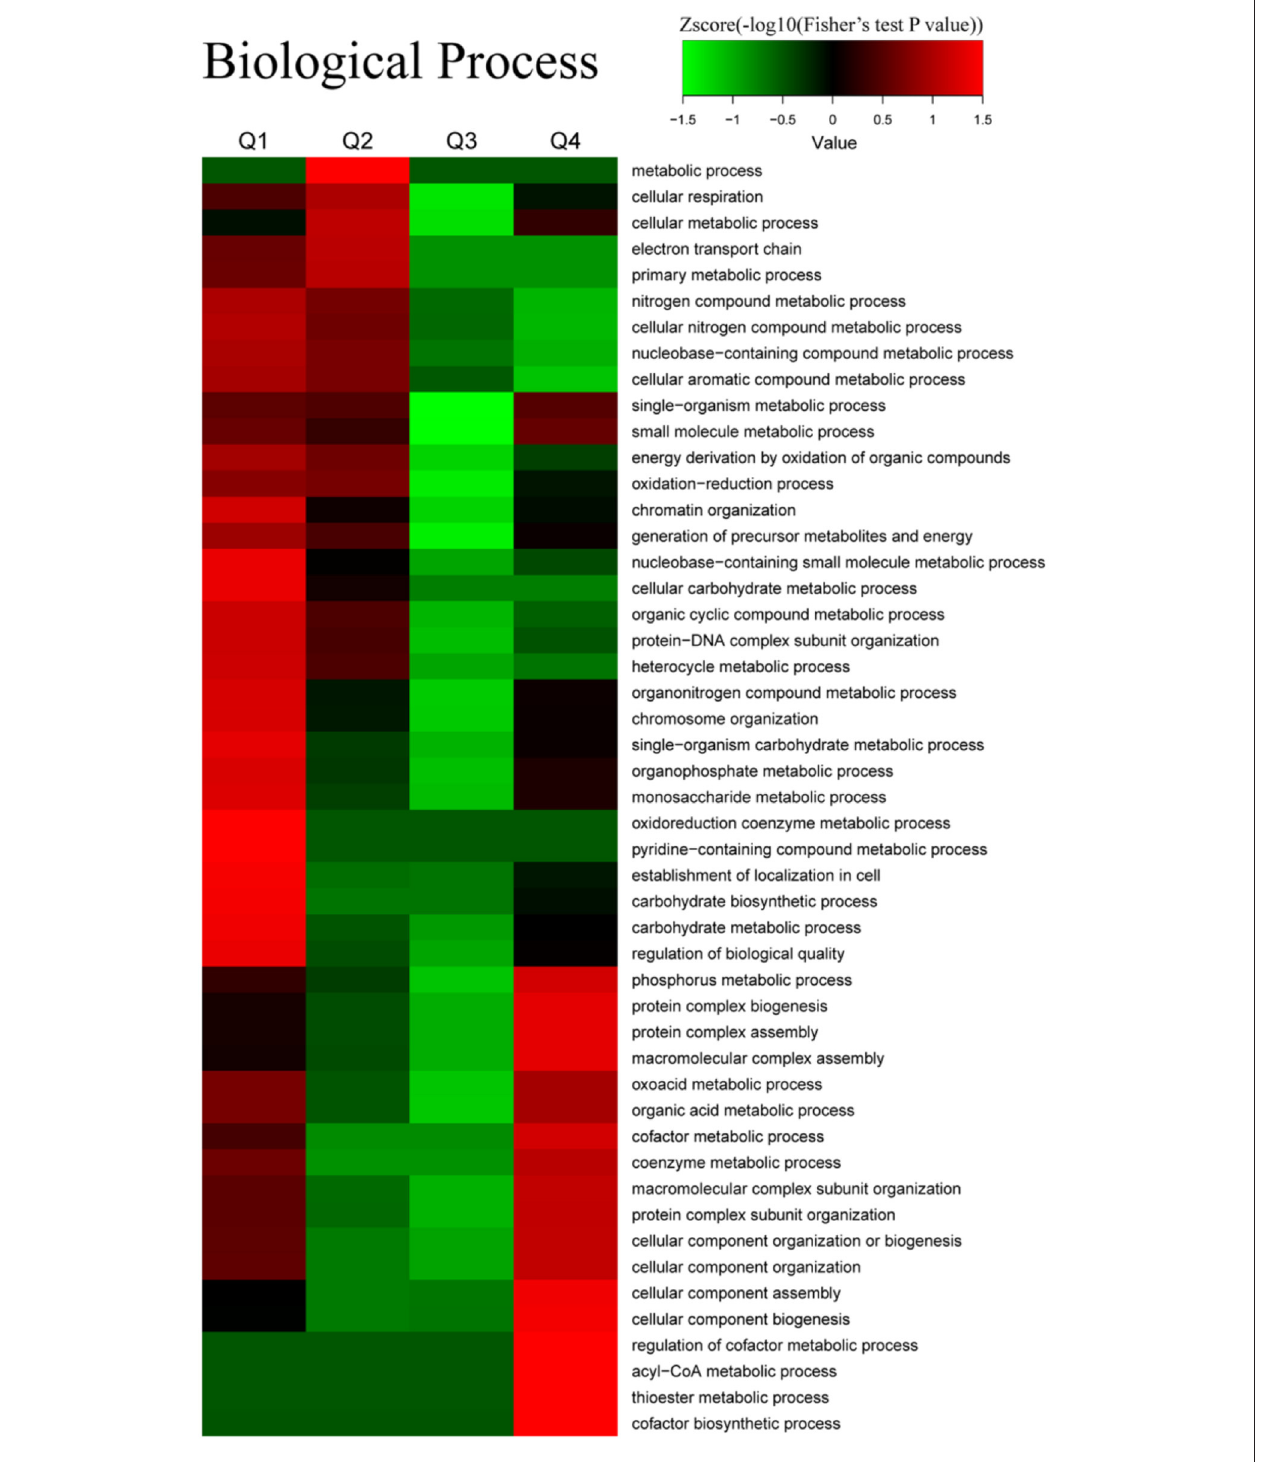
FIGURE 7 | Enrichment and clustering analysis of the quantitative acetylome data sets in naive CD4 + T cells and iTfh cells based on the biological process. All of the quantified acetylation proteins were also divided into four quantiles (Q1–Q4) according to Tfh/N ratios: Q1 (0 < Ratio T/N < 0.667), Q2 (0.667 < Ratio T/N < 0.77), Q3 (1.3 < Ratio T/N < 1.5), and Q4 (Ratio T/N > 1.5).